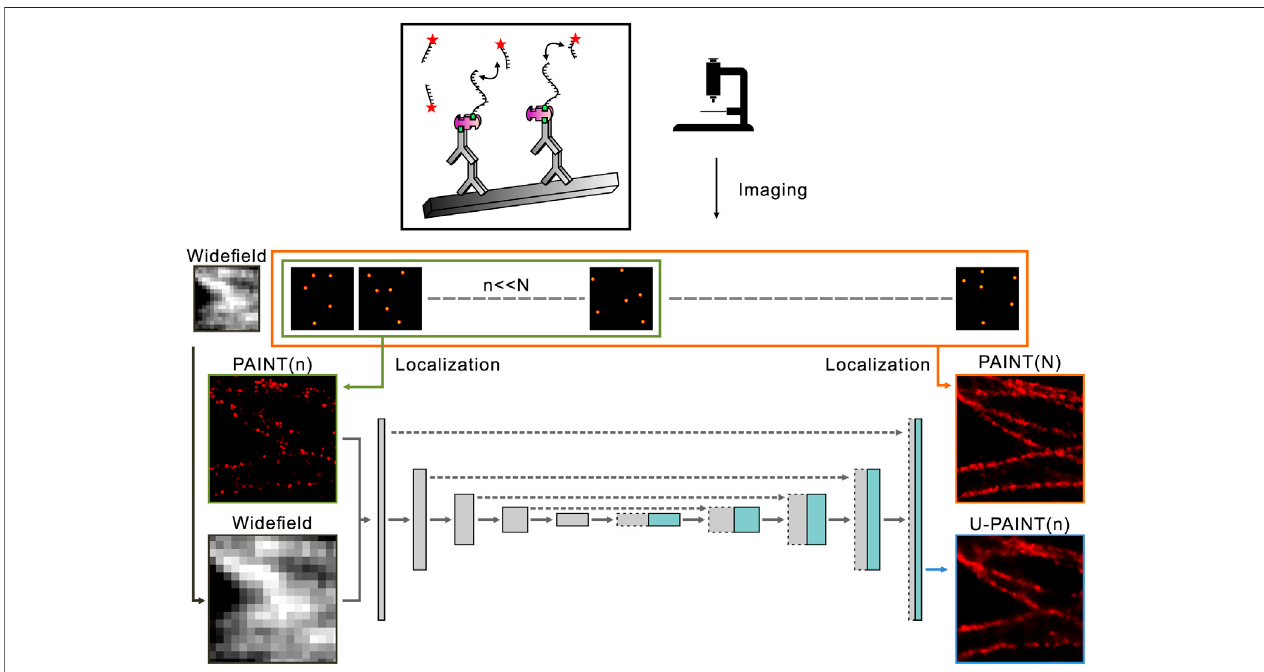
FIGURE 2 | Overview of U-PAINT. Training images are localized and rendered from long sequences of single-molecule image frames or wide fi eld images. Sparse localizationimagesfromthe fi rstnframesandwide fi eldimagesaresetasinputsofU-PAINT,whiledenselocalizationimagesofNframes(N >> n )areoutputs.Simulated microtubule data enhance U-PAINT